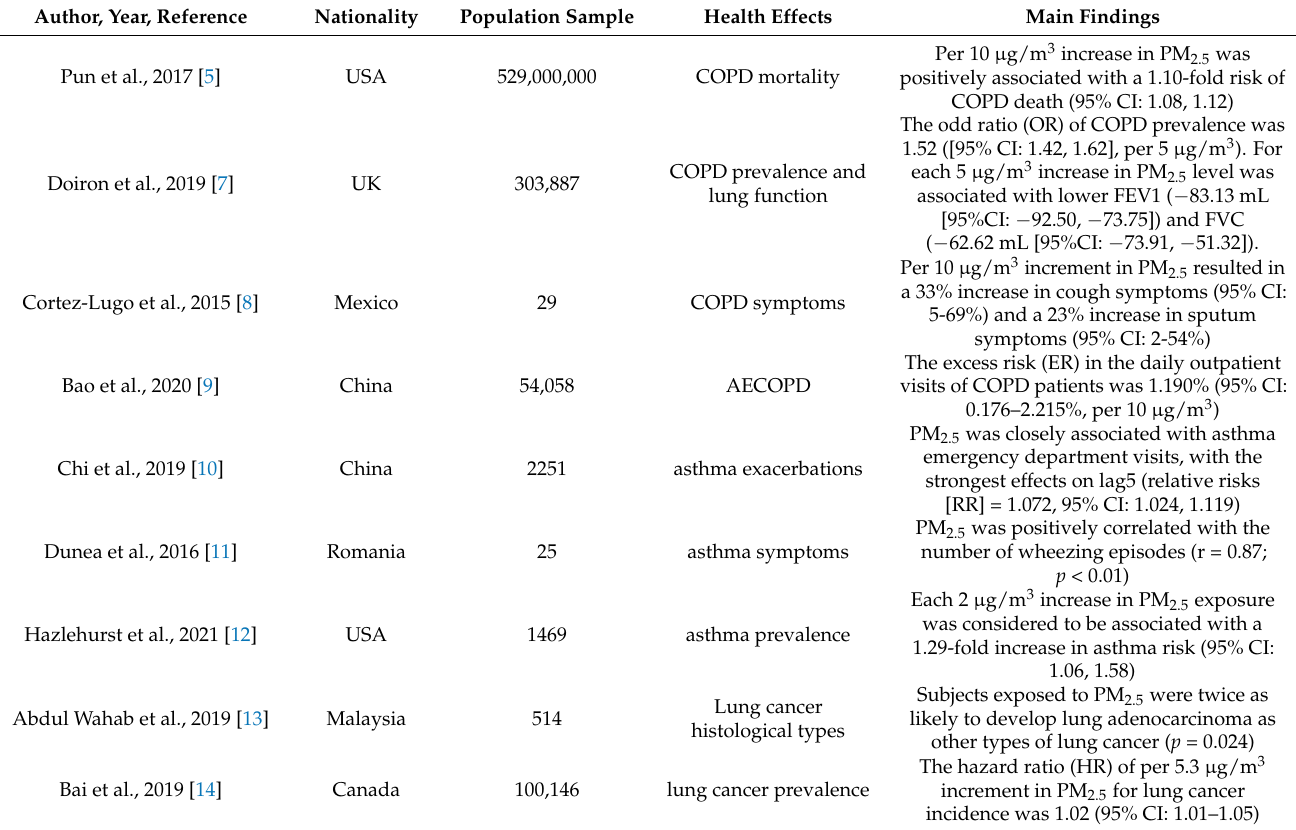
Table 1. Associations between PM 2.5 and chronic airway